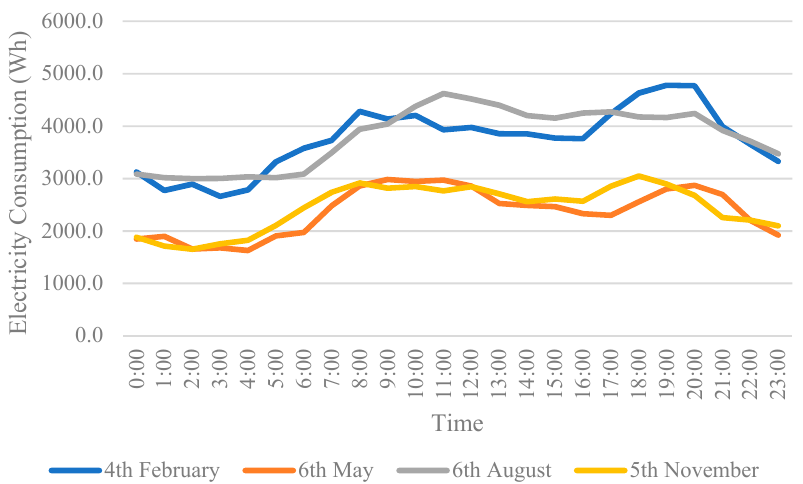
Figure 5. Comparison of the hourly average electricity consumption profiles for a high-consumption household during the four seasons.